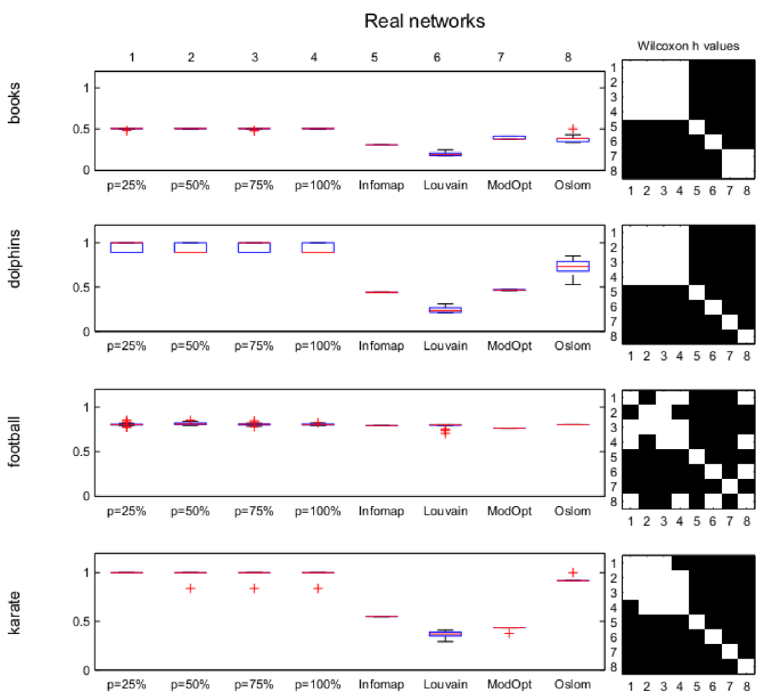
Fig 9. Real-world networks; boxplots of NMI values for all methods considered (left). On the right, the black-white matrix represents Wilcoxon h values for each pair of methods considered, numbered in the order they appearin the boxplot. A black squareindicates a statistical difference betweenresults.